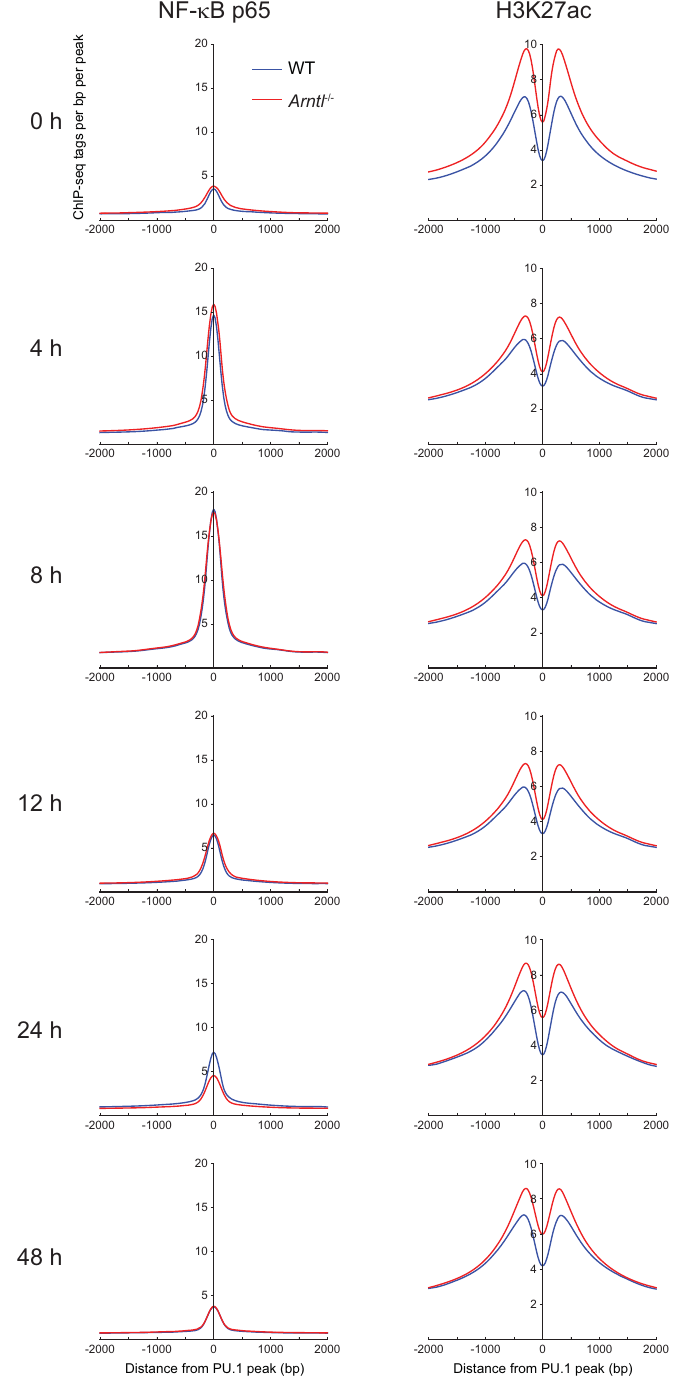
Figure 4. Average recruitment of NF- κ B p65 to all PU.1 binding sites are unaffected by Arntl deletion. NF- κ B p65 and H3K27ac read density in the vicinity of PU.1-dinging sites in WT and Arntl − / − macrophages treated with KLA for indicated